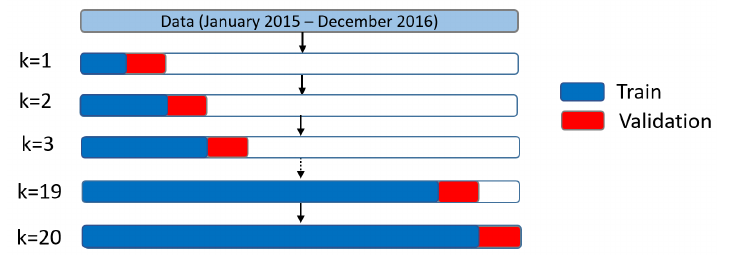
Figure 3. Evaluation of model performance using time series cross-validation with 20 folds to prevent overfitting and evaluate model performance in a robust way. The final metric is calculated as the average RMSE of every cross-validation